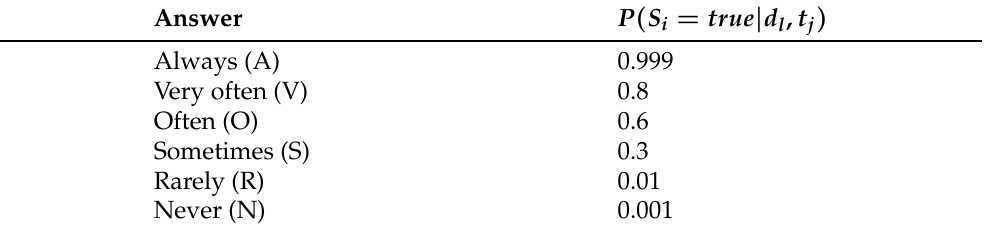
Table 1. Scale to convert expert answers into probability